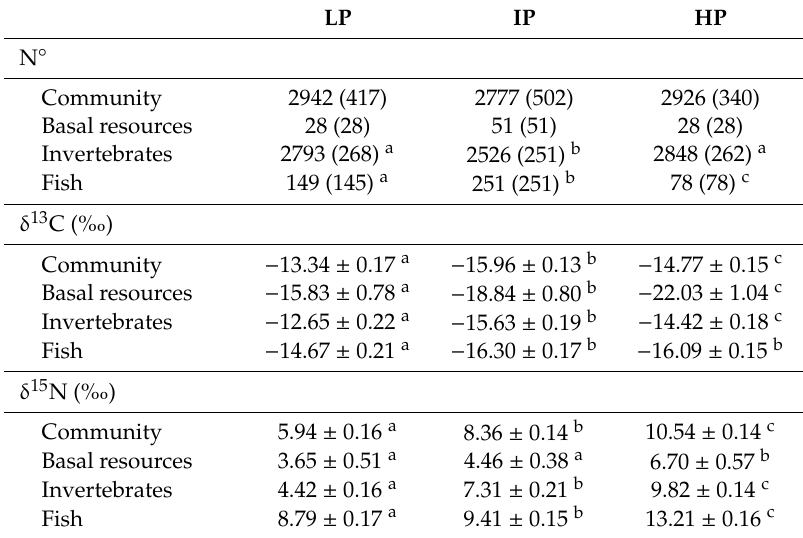
Table 1. Parameters describing the communities in each Lake. LP, IP and HP: low, intermediate and high eutrophication. N ◦ indicates the sample size. Numbers in parentheses indicate the number of samples analysed. Community indicates both fish and benthic invertebrates. Stable isotopes of δ 13 C and δ 15 N are reported as mean (% (cid:24) ) ± s.e. For each parameter, di ff erent superscript letters (a,b,c) indicate di ff erences between lakes (one-way ANOVA or Mann–Whitney test; p < 0.05). LP